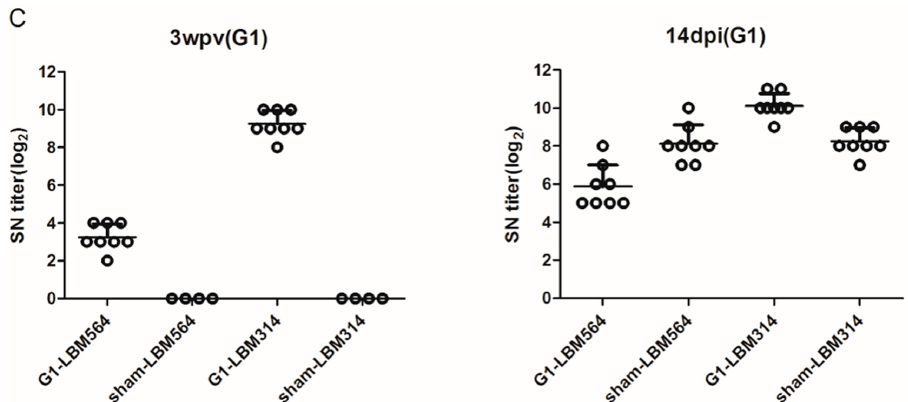
Figure 2. Antibody responses induced by vac564 and G1 lineage vaccines at 3 weeks post-vaccination (wpv) and at 14 days post-infection (dpi). Hemagglutination inhibition (HI) and serum neutralization (SN) assays were performed. ( A ): vac564 vaccination-challenged group. Black circles indicate the HI titers. ( B ): G1 vaccination-challenged group. Black circles indicate the HI titers. ( C ): G1 vaccination-challenged group. White circles indicate the SN titers. For serum analyses, G1 used the challenge strain as the antigen.